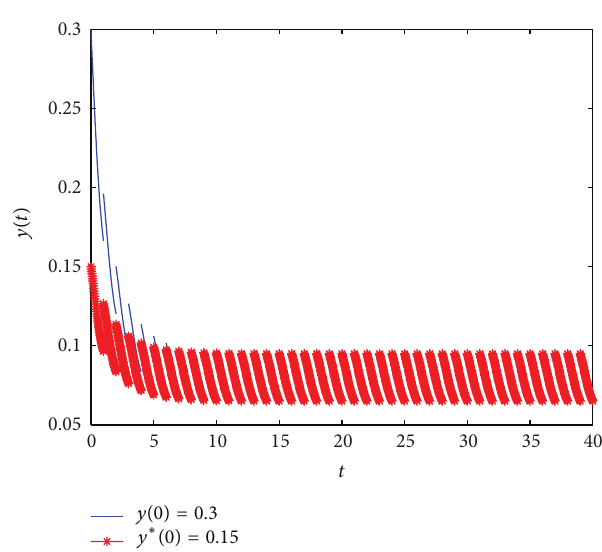
Figure 4: Global attractivity of system (7a) and (7b) with 𝑦(0) = 0.3 , 𝑎(𝑡) = −0.2 + 0.1 cos 2𝜋𝑡 , 𝑏(𝑡) = 1.5 + 0.1 sin 2𝜋𝑡 , 𝑐(𝑡) = 0.11 + 0.1 cos 2𝜋𝑡 , 𝑑(𝑡) = 1.5 + cos 2𝜋𝑡 , and 𝑝 = 0.03 . The positive solution 𝑦 ∗ (𝑡) with 𝑦(0) = 0.15 tends to the positive solution 𝑦(𝑡) with 𝑦(0) = 0.3